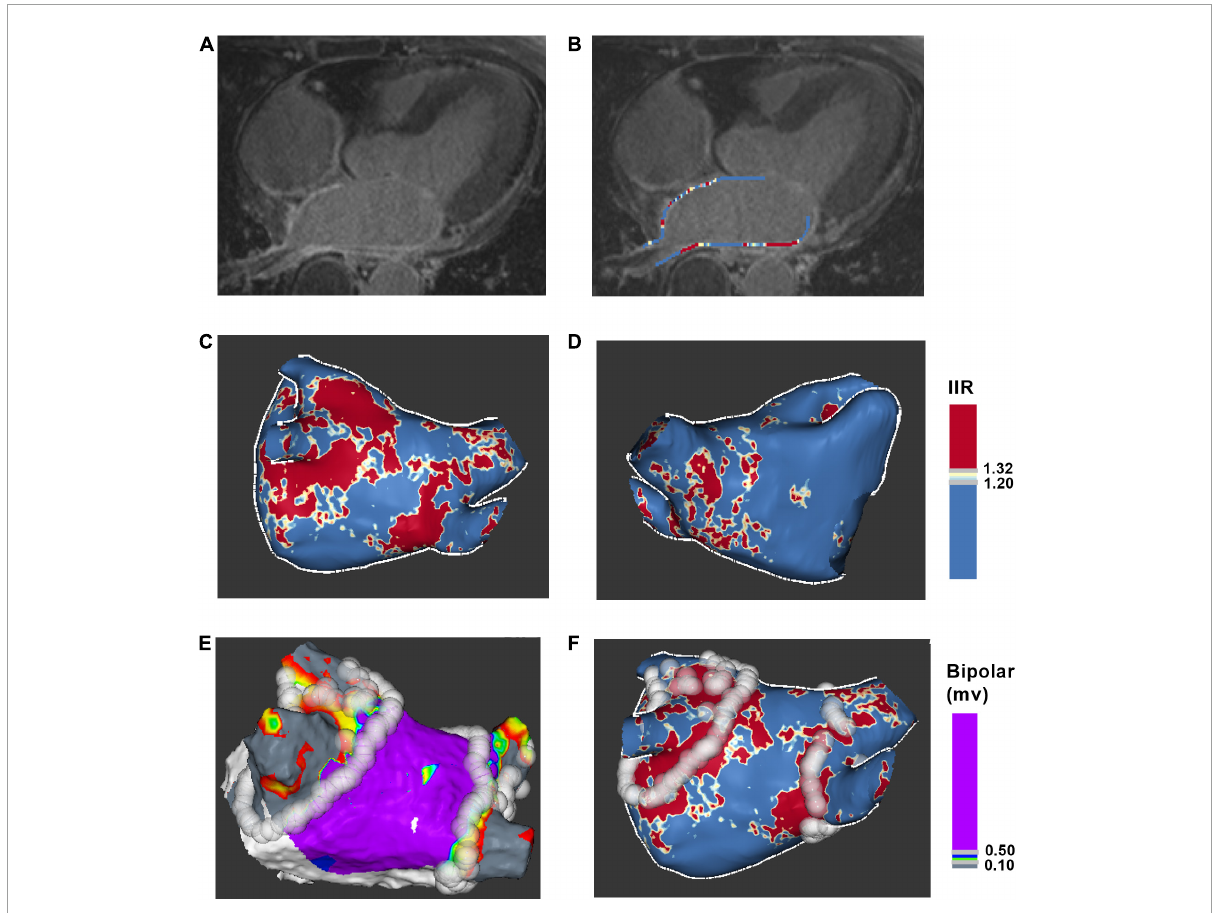
FIGURE2 Process for ablation points projected onto LGE-CMR left atrial shell. (A) Acquire axial view of left atrium. (B) Manually drawn left atrial wall contour. (C) Posterior view of 3D color-coded LGE-CMR shell. (D) Anterior view of 3D color-coded LGE-CMR shell (E) 3D electroanatomic map of left atrium. (F) The merge of LGE-CMR shell and electroanatomic map. Ablation points were projected onto the surface of 3D LGE-CMR shell of left atrium. IIR, image intensity